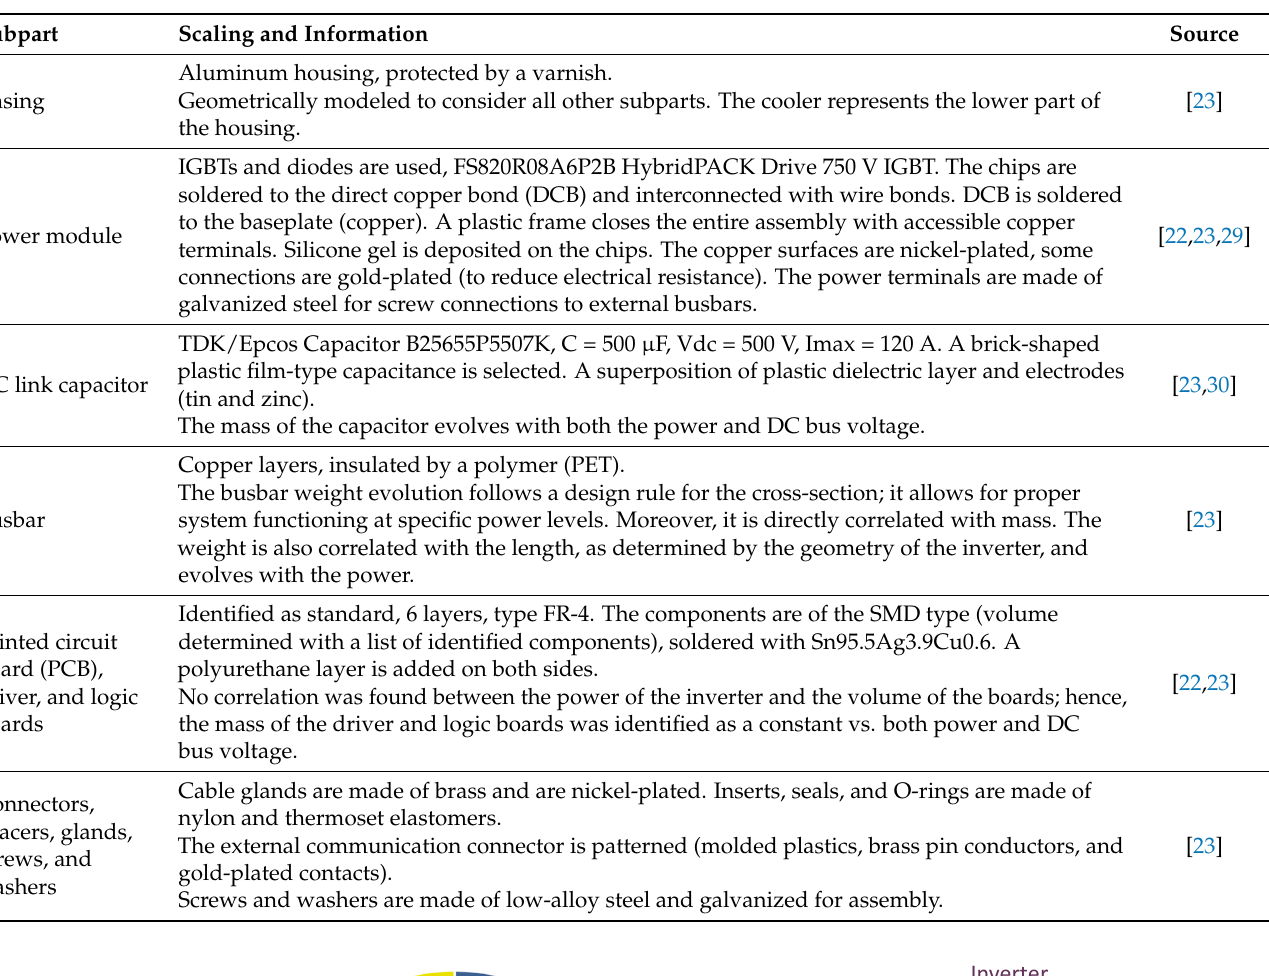
Table 2. Composition of the inverter.